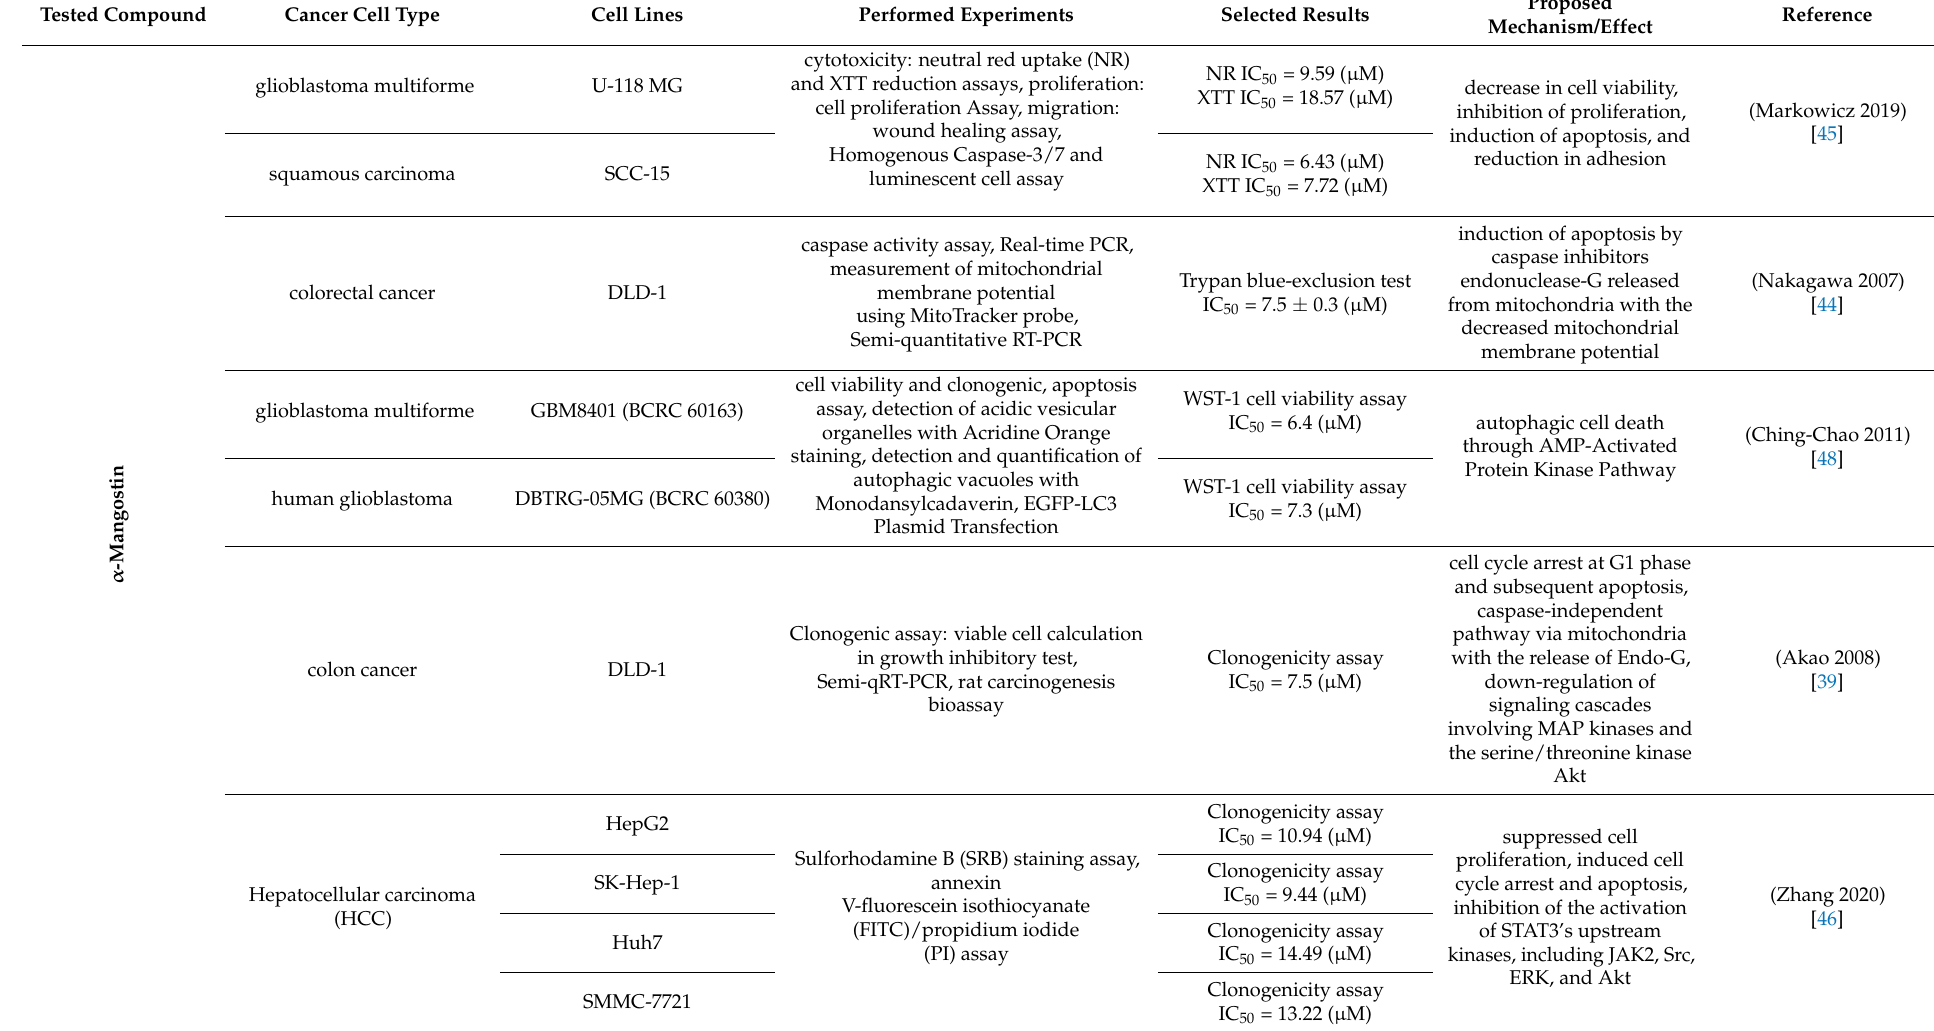
Table 1. Xanthone derivatives cytotoxic toward tumor cell lines within CNS and their anticancer